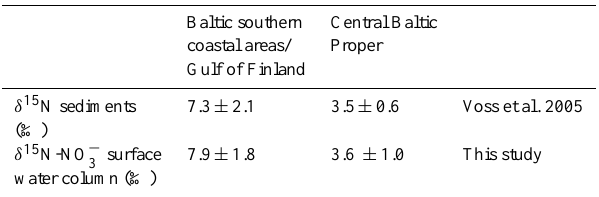
Table 4. Comparison of δ 15 N-NO − ples and δ 15 N values from sediments samples in sub-regions of the Baltic